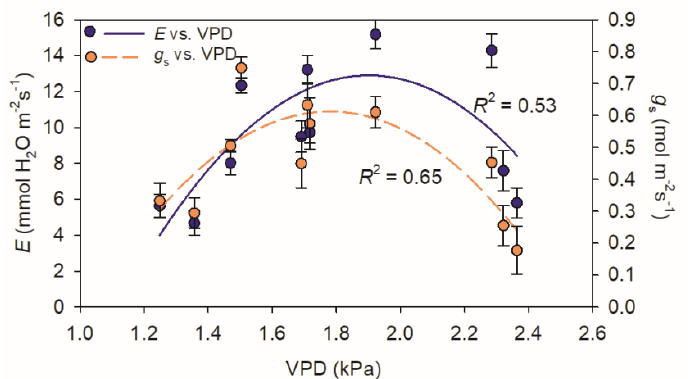
Figure 4. Variation of leaf transpiration ( E , mmol H 2 O m −2 s −1 ) and stomatal conductance ( g s , mol m −2 s −1 ) in relation to the increase of the vapor pressure deficit (VPD, kPa) in the atmosphere under full irrigation (F treatment) in processing tomatoes cv. Hypeel F1. Measurements were made between 11:00 and 13:00, with PAR (Photosynthetic active radiation) varying from 1500 to 2000 μmol m −2 s −1 as measured by the PAR sensor of the porometer. Symbols represent the observed values. Black vertical bars represent the standard error.